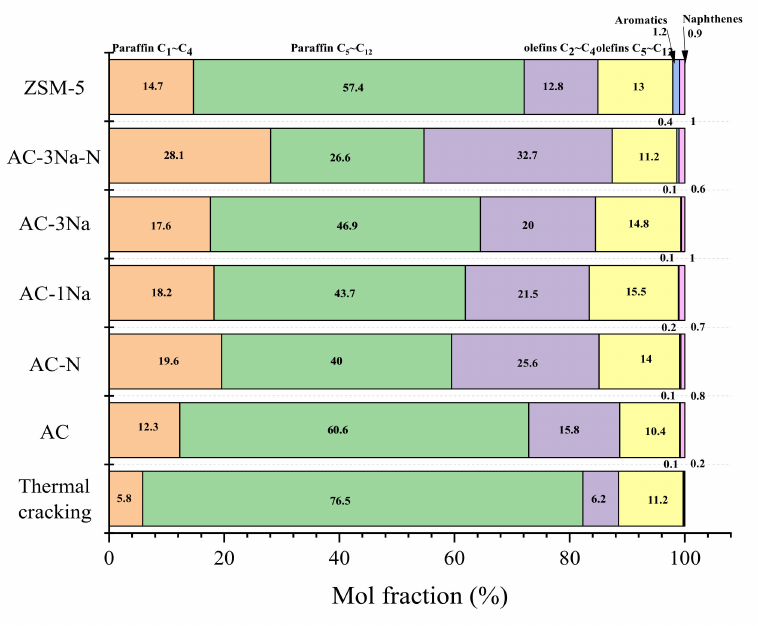
Figure 8. Overall product distribution at 450 ◦ C and 4